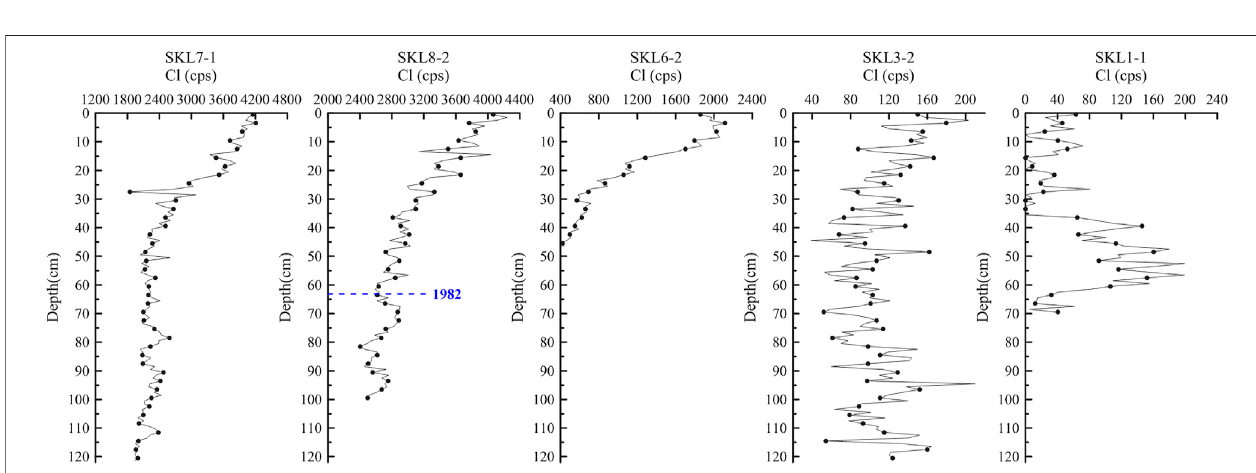
FIGURE4| Verticalvariationsofchlorinecontentat fi vestationsinSongkhlaLake(distancefromthechannelconnectedwiththeGulfofThailand:SKL7-1 < SKL8-2 < SKL6-2 < SKL3-2 < SKL1-1).